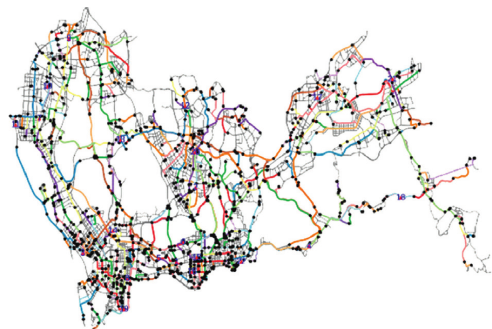
Figure 13: Planned path before